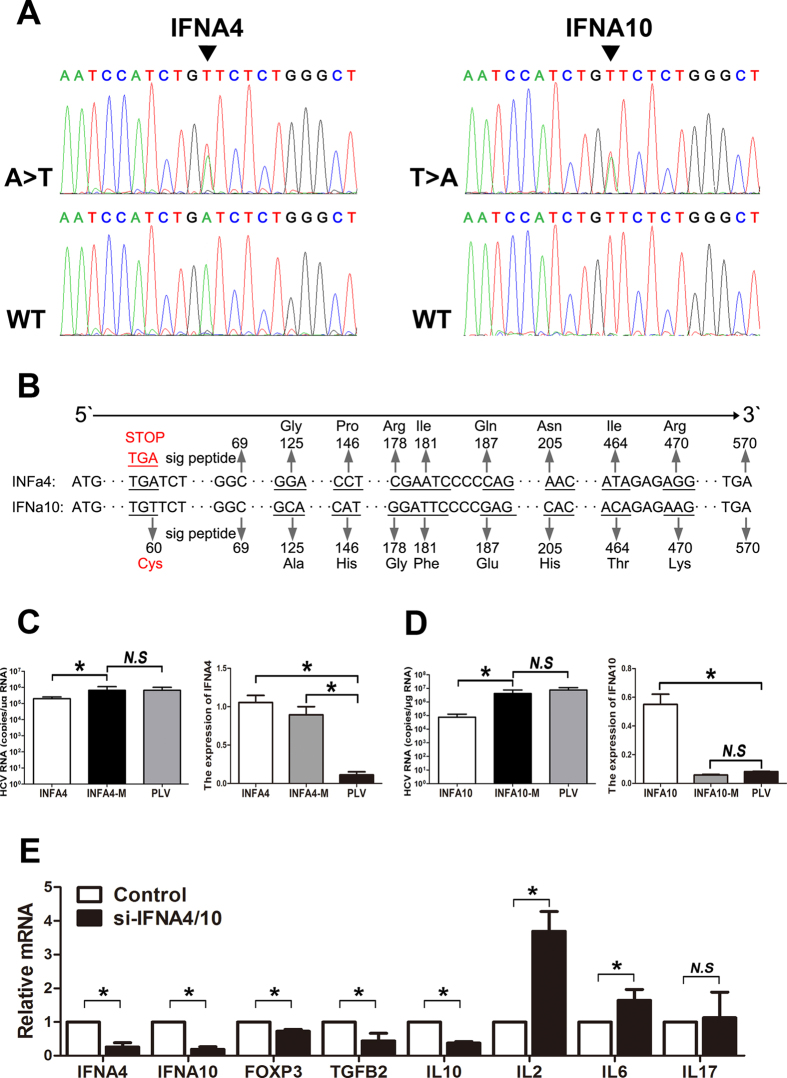
Sequencing and functional analysis of the IFNA4 and IFNA10 variants. (A) Confirmation of the IFNA4 and IFNA10 heterozygous mutations in CD patients compared to healthy subjects (wild-type alleles) using Sanger sequencing. (B) The mutation site and amino acids alteration of the IFNA4 and IFNA10 variants. (C-D) Huh7 cells were transiently transfected with plasmids expressing IFNA4, IFNA10, or mutants and then infected with HCV; the replicon copies were calculated using real-time PCR and PLV as a control; The supernatants of the cell culture were analyzed using ELISA. (E) Real-time PCR analyzed the mRNA expressions of IFNA4, IFNA10, FOXP3, TGFβ, IL10, IL2, IL6 and IL17 in NCM460 cells after transfection of the siRNA targeting IFNA4 and IFNA10. The scramble siRNA sequences were used as a negative control. The results indicate the mean ± SD of three independent experiments (*P < 0.05).